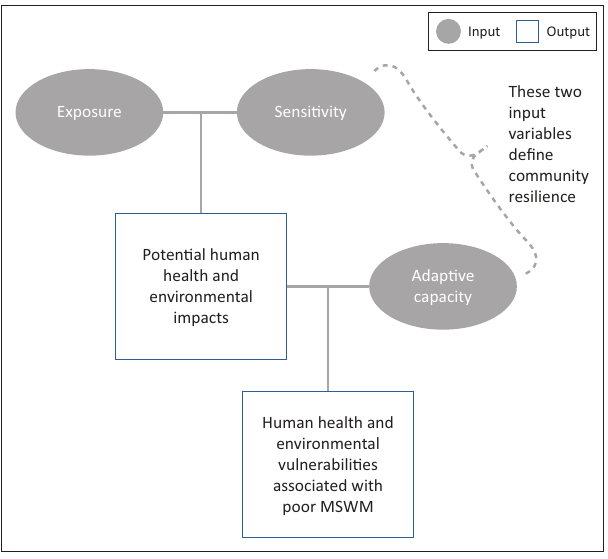
FIGURE 2: Vulnerability context variables defining municipal solid waste management-induced human health